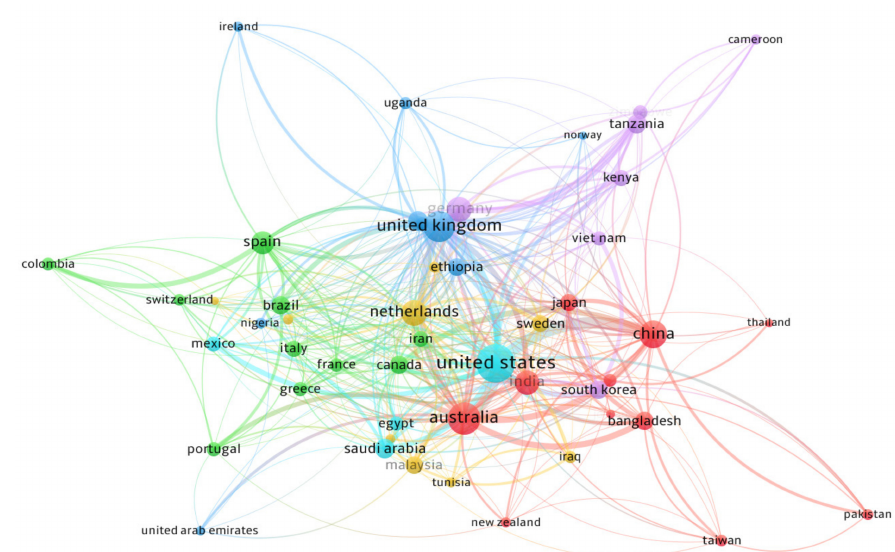
Figure 9. Network visualization map of country co-authorship in the RWH field. Countries with a minimum of five published and cited articles were included. Number of countries met the thresholds was 69 out of 159 countries and the map includes 50 out 69 countries. Total link strength of top 5 countries are as follows: USA = 258, Australia = 182, United Kingdom = 164, China = 127 and The Netherlands = 108.